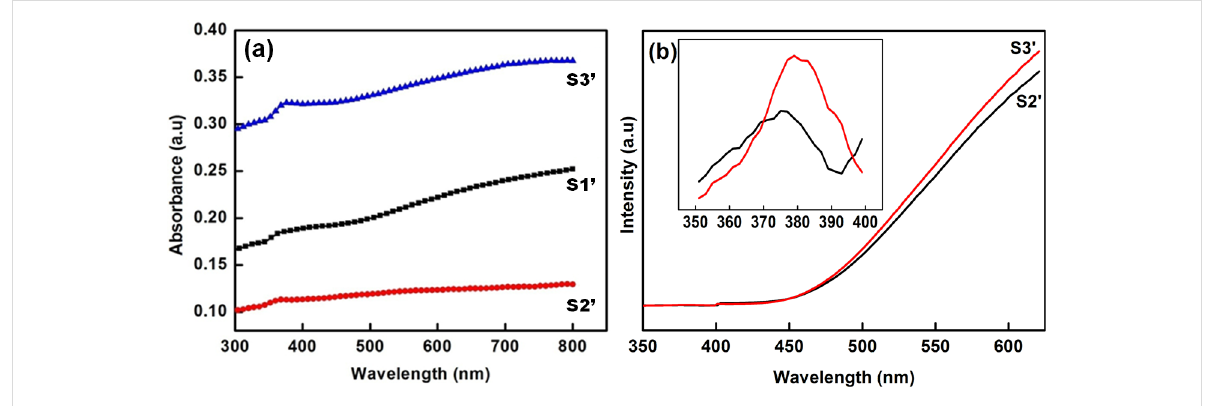
Figure 6: (a) UV–vis absorption spectra of aged samples S1’, S2’ and S3’, (b) room temperature PL spectra, inset showing the NBE emission peak in the aged ZnO samples.